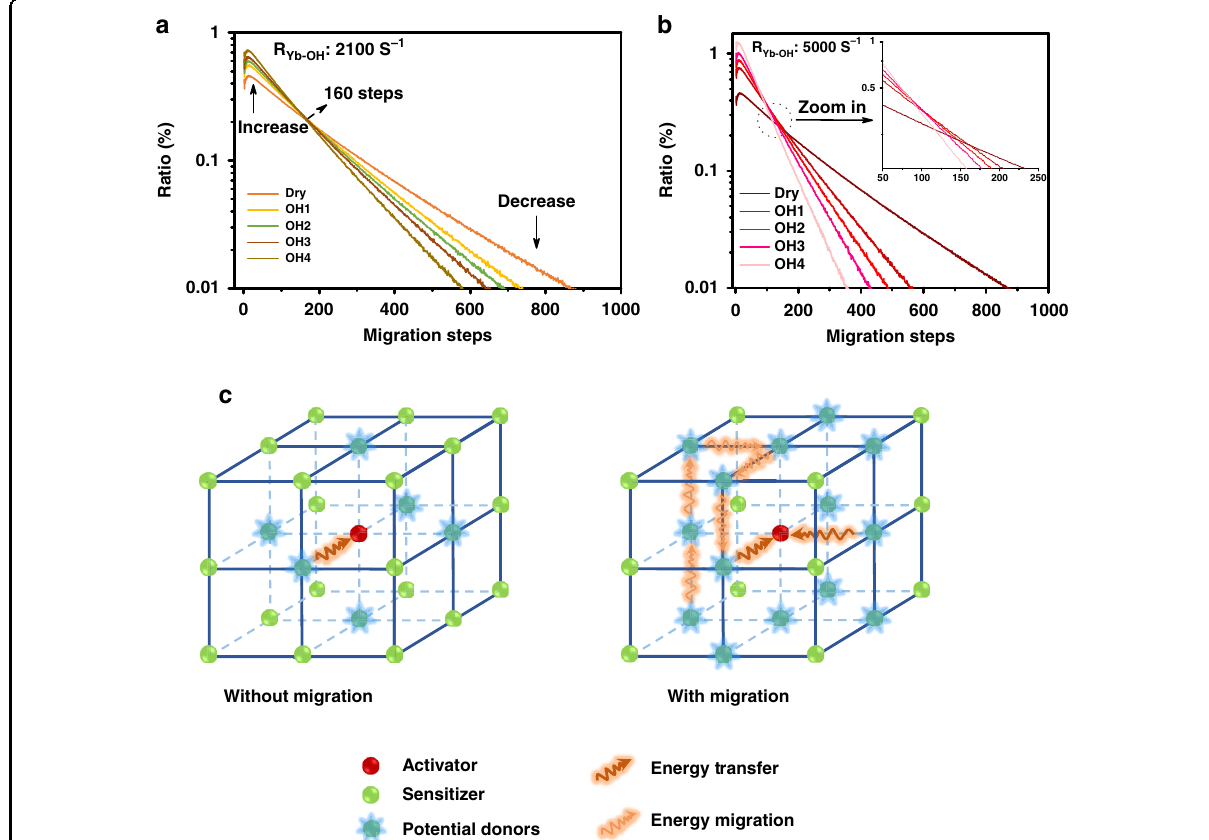
Fig. 4 Simulated Yb 3 + – Yb 3 + energy migration step distribution. The simulated Yb 3 + – Yb 3 + migration steps distribution in series OH − in fl uenced samples (Dry, OH1 – 4 core/shell structures): a the R Yb-OH is set to 2100 s − 1 , b the R Yb-OH is set to 5000 s − 1 . Each curve in a , b is normalized by its area. c Schematic diagram of the migration steps related Yb 3 + → Er 3 + energy transfer